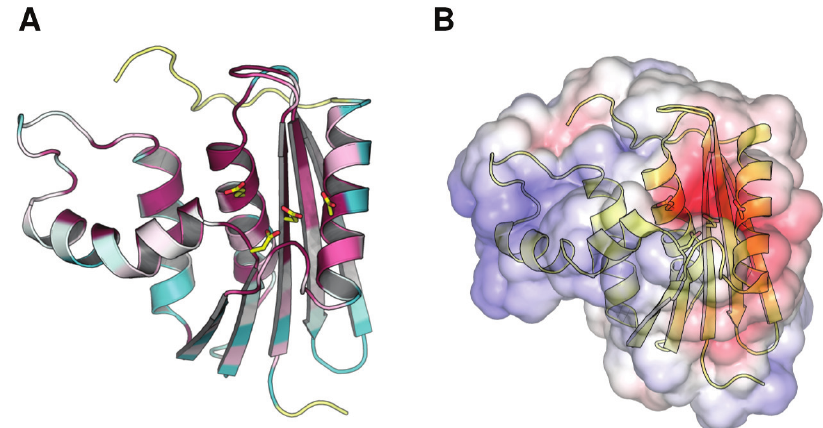
Figure 1. Conservation of the ribonuclease H active site. ( A ) Residue conservation among bacterial RNase H homologs mapped onto the structure of ecRNH (PDB ID 2RN2). Highly conserved residues are shown in red, highly variable residues in green, and sites with insufficient data in yellow. Image produced using ConSurf. ( B ) Electrostatic map of the solvent-accessible surface of ecRNH produced using APBS. Red represents regions of negative charge and blue represents regions of positive charge. The active-site residues are represented as sticks in both